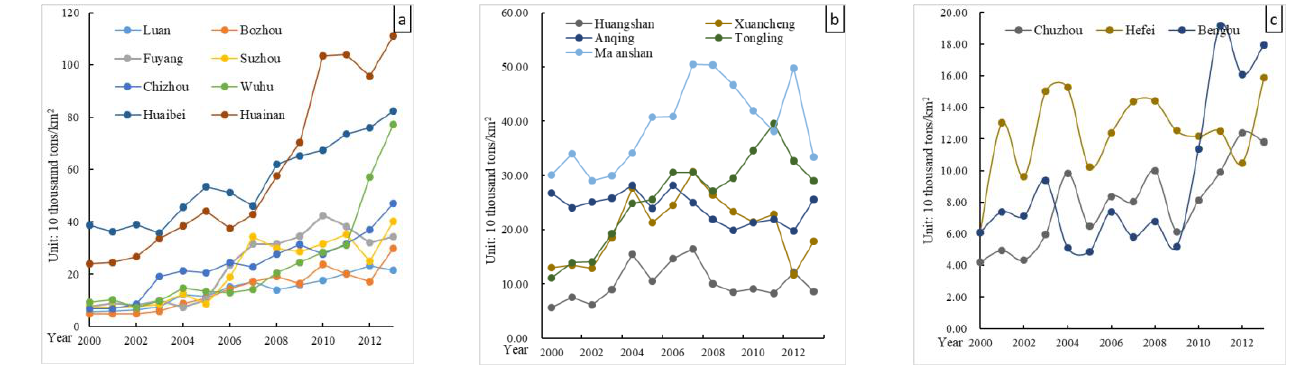
Figure 8. Changes in CEIIL of 16 prefectural cities in Anhui Province from 2000 to 2013: ( a ) cities with a continuous increase; ( b ) cities with a first increase followed by a decrease; and ( c ) cities with fluctuating increase.